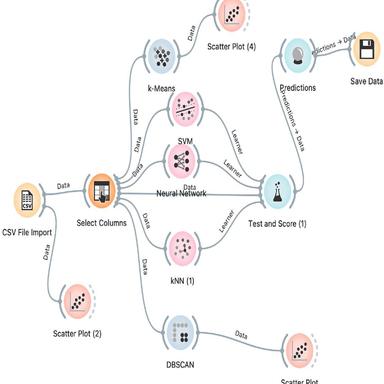
Methodology diagram for machine learning by the Orange software. (For interpretation of the references to color in this figure legend, the reader is referred to the web version of this article.)